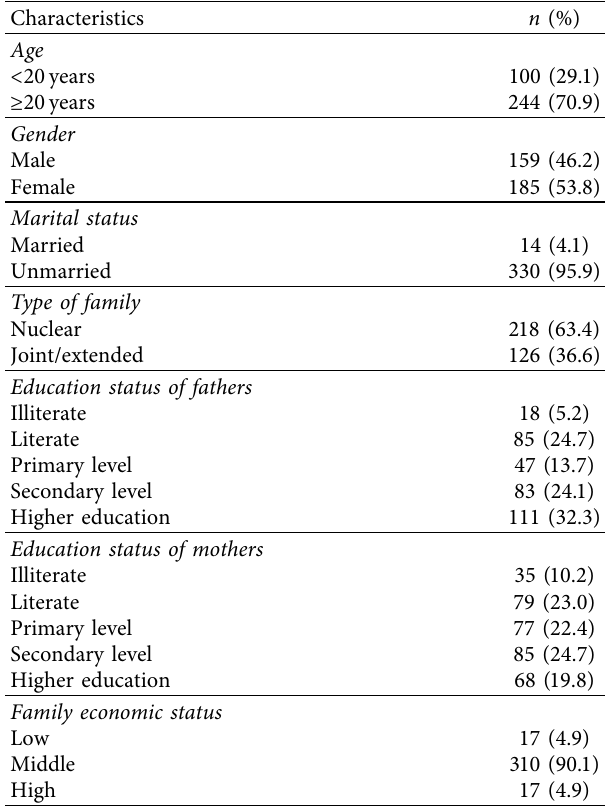
Table 1: Sociodemographic profle of the participants.